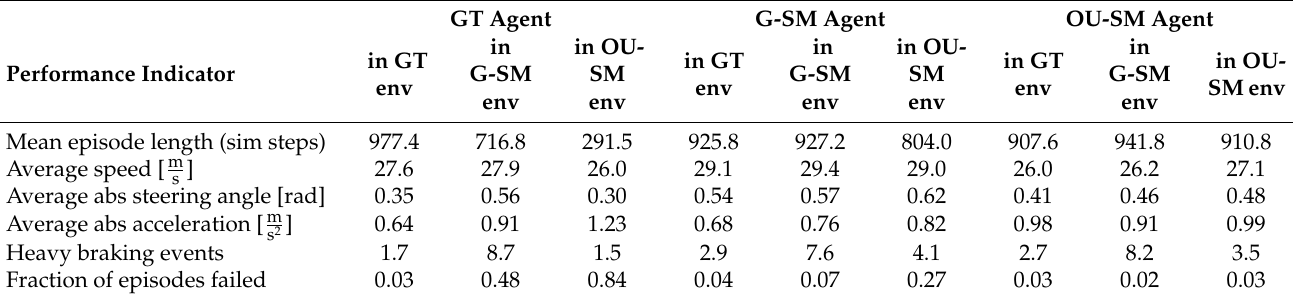
Table 1. Key Performance Indicators for evaluated agents. The table summarizes the evaluation of three driving policies (GT agent - policy trained in the ground-truth environment, G-SM agent - policy trained in the environment with baseline sensor models based on Gaussian noise, and OU-SM agent, which was trained in an environment with sensor models proposed in previous chapters). Each policy was evaluated in three simulation environments - with GT data, with G-SM setup, and with OU-SM